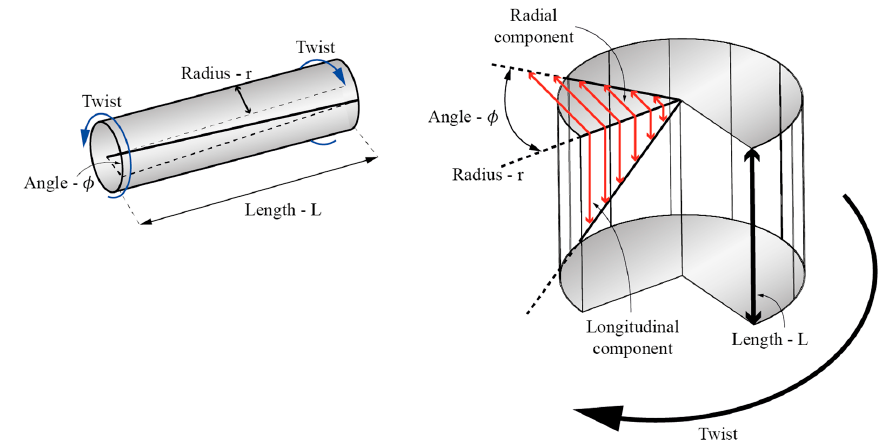
Figure 7. Shear stress distribution along the twisted rod/fiber.